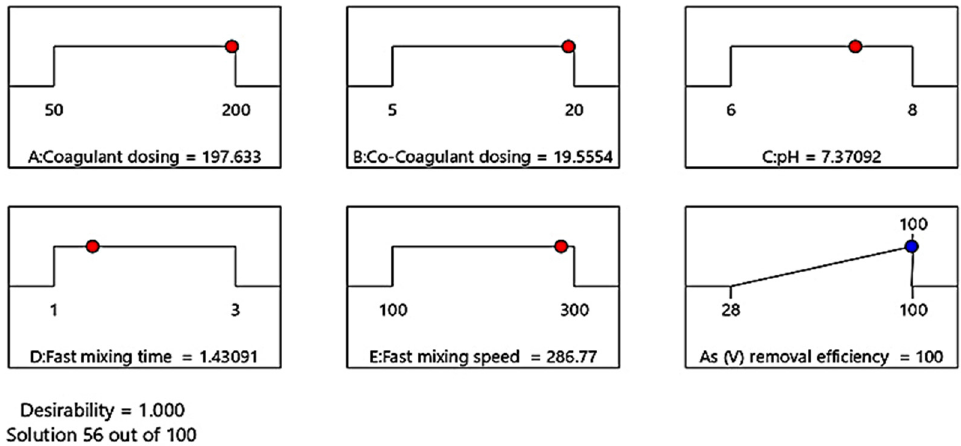
Figure 3. The optimal condition of As(V) removal process with the coagulation-flocculation method. To confirm the model prediction, the As(V) removal process was repeated under the optimal conditions with the Nazarabad well water sample containing the specific As(V) concentration of 5 mg/L with three repetitions. Under the suggested optimal conditions of the model, the experimental result of the complete (100%) removal of As(V) from the real well water sample was obtained, which confirms high accuracy of the proposed model based on the response surface method for predicting the optimal conditions of As(V)